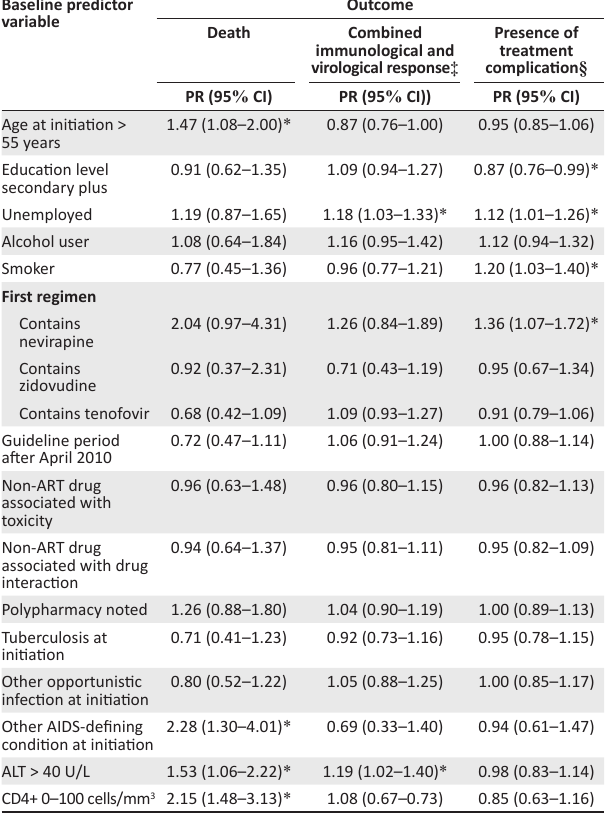
TABLE 3: Adjusted baseline predictors of death, combined immunological and virological response, and presence of treatment complication at 12 months for subjects older than 50 years at antiretroviral therapy initiation.